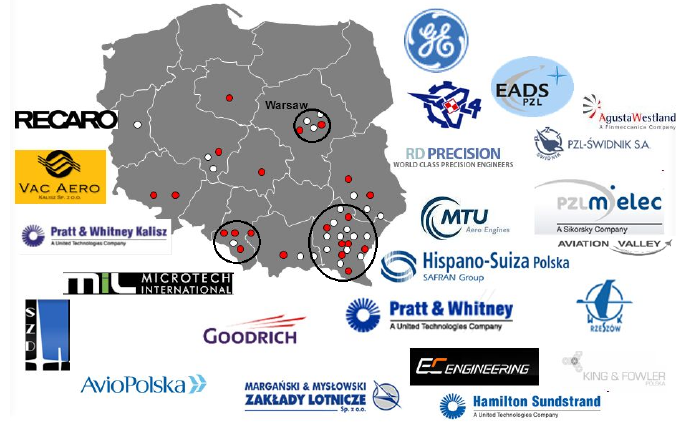
Figure 1: The aviation industry in